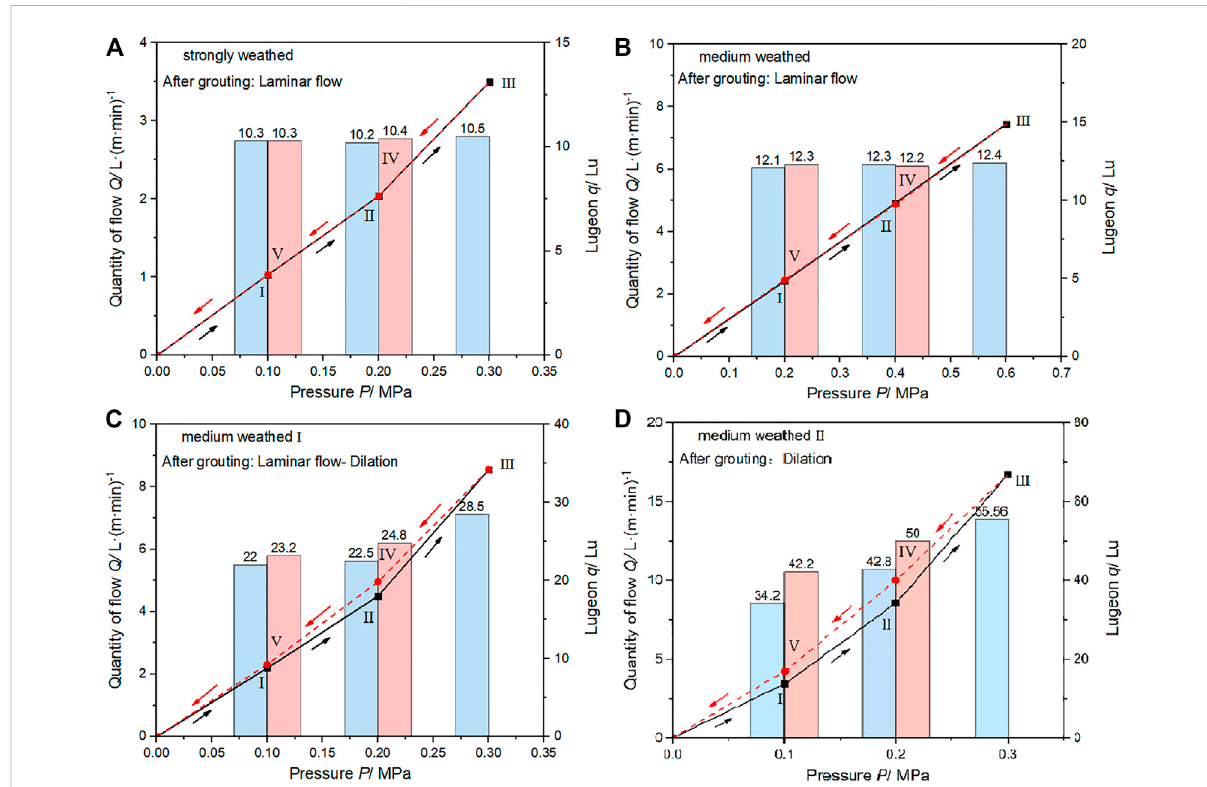
FIGURE 9 Formation permeability after grouting (A) strongly weathered formation of No. 1 test area, (B) medium weathered formation of No.1 test area, (C,D) the upper and lower weathered formation of No. 2 test area.